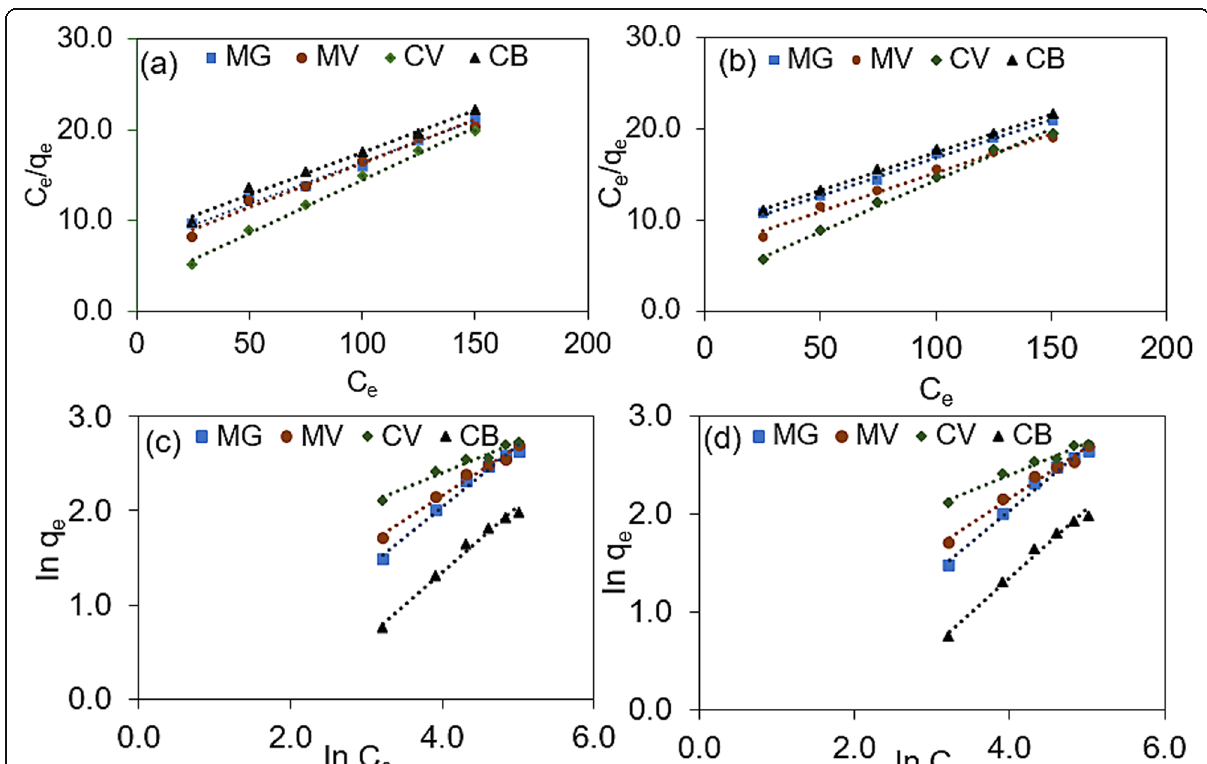
Fig. 11 Isotherm models based on (a) Langmuir model for the sorption of TPM dyes by live and (b) dead cells; (c) Freundlich model for the sorption of TPM dyes by live and (d) dead